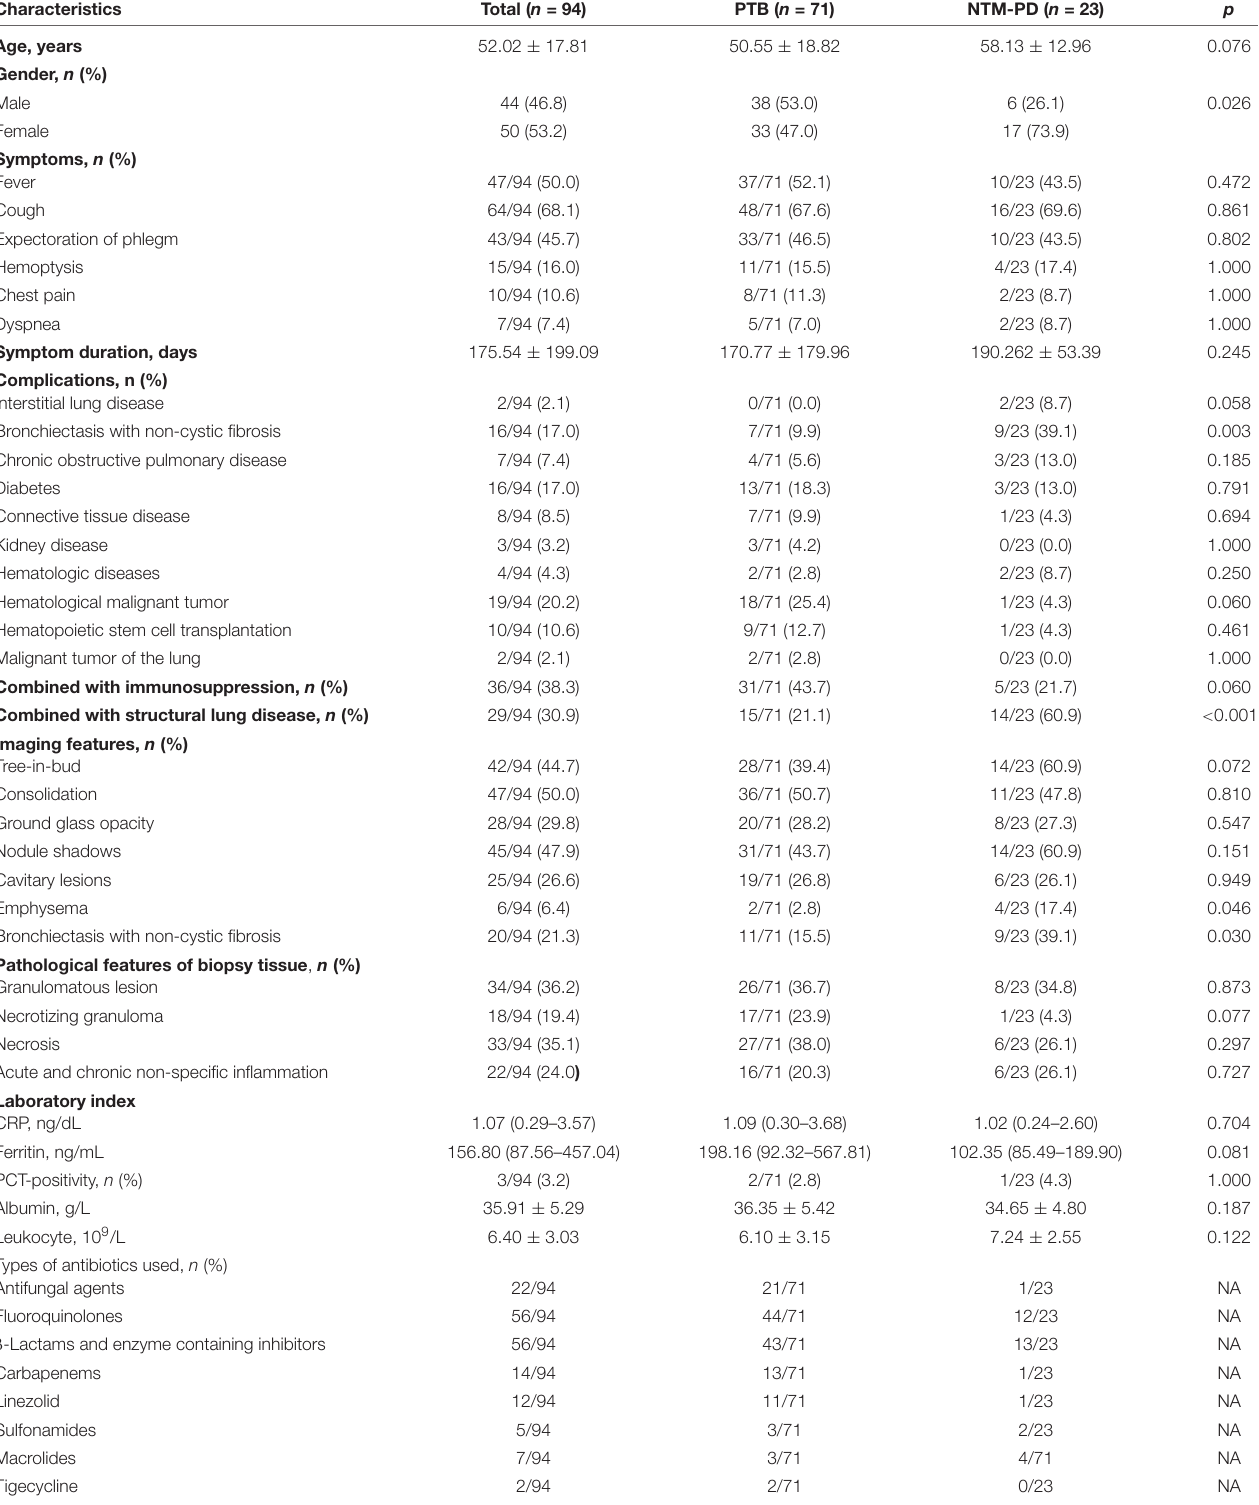
TABLE 1 | Baseline characteristics and clinical indices of PTB and NTM-PD subjects.